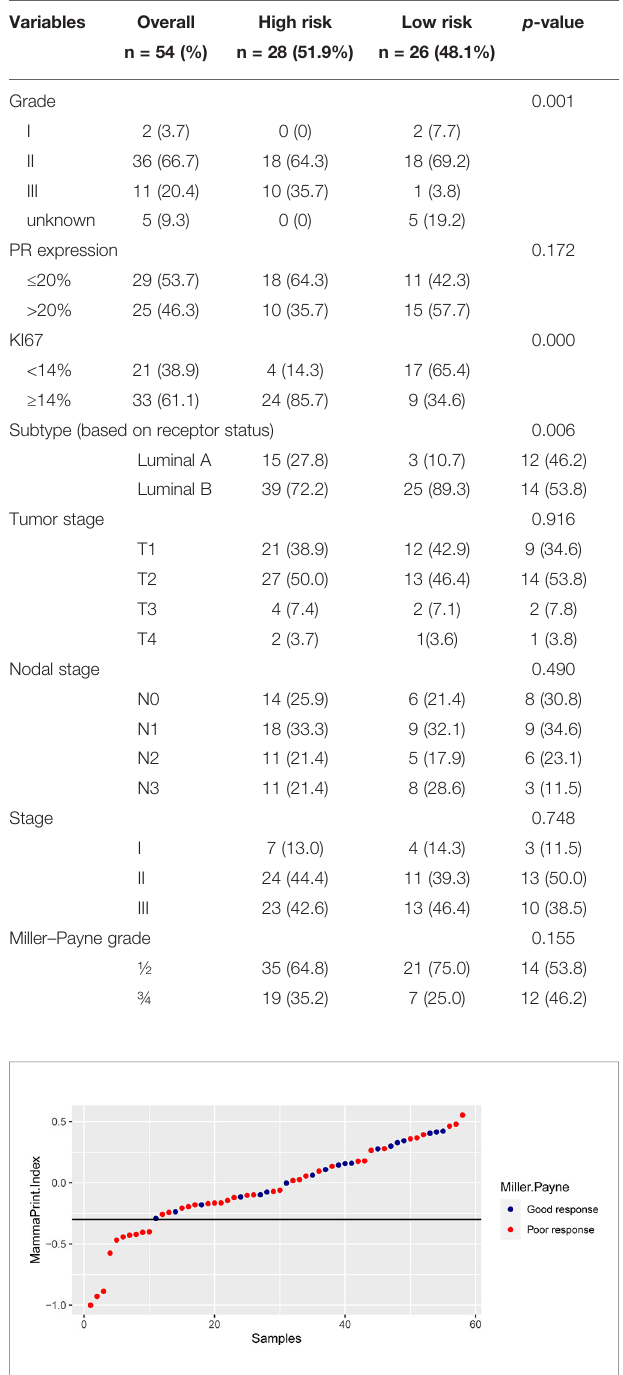
TABLE 4 | The tumor characteristics of postoperative and the association with the 70-gene